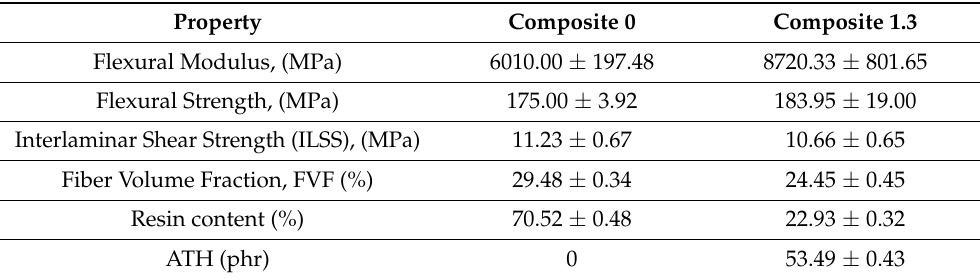
Table 5. Mechanical properties of different composite formulations.